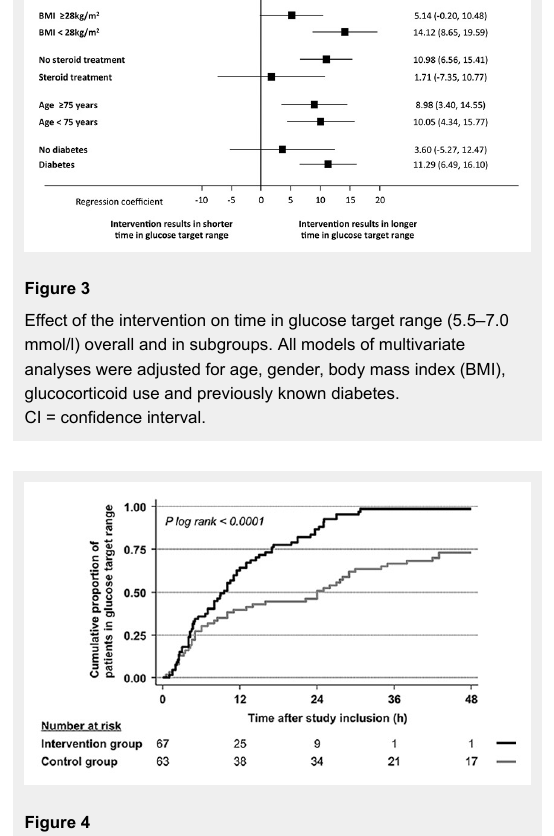
Cumulative proportion of patients in the two groups reaching the glucose target range after inclusion in the